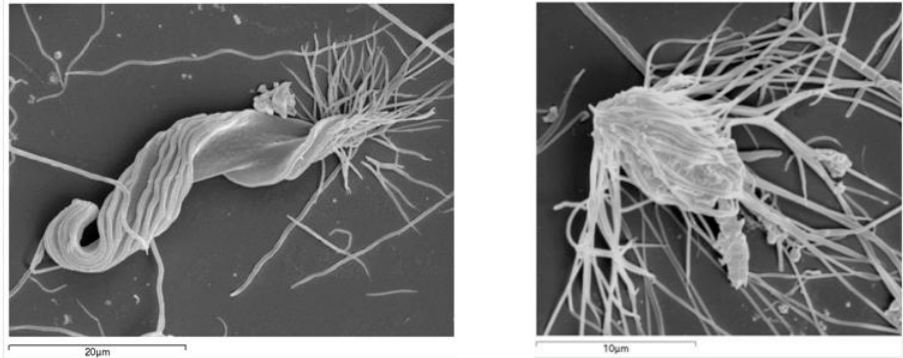
Figure 1. Scanning electron micrograph for: morphotype n2 ( Pyrsonympha sp.; Preaxostyla, Oxy- monadida) ( left ), and morphotype n8 ( Microjoenia hexamitoides ; Parabasalia, Spirotrichonymphida) ( right ).